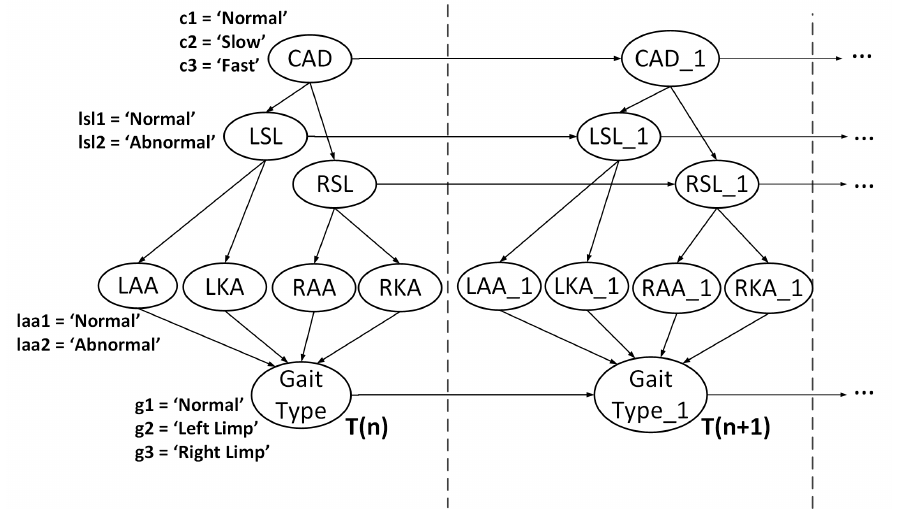
Figure 7. Proposed DBN for gait type recognition.